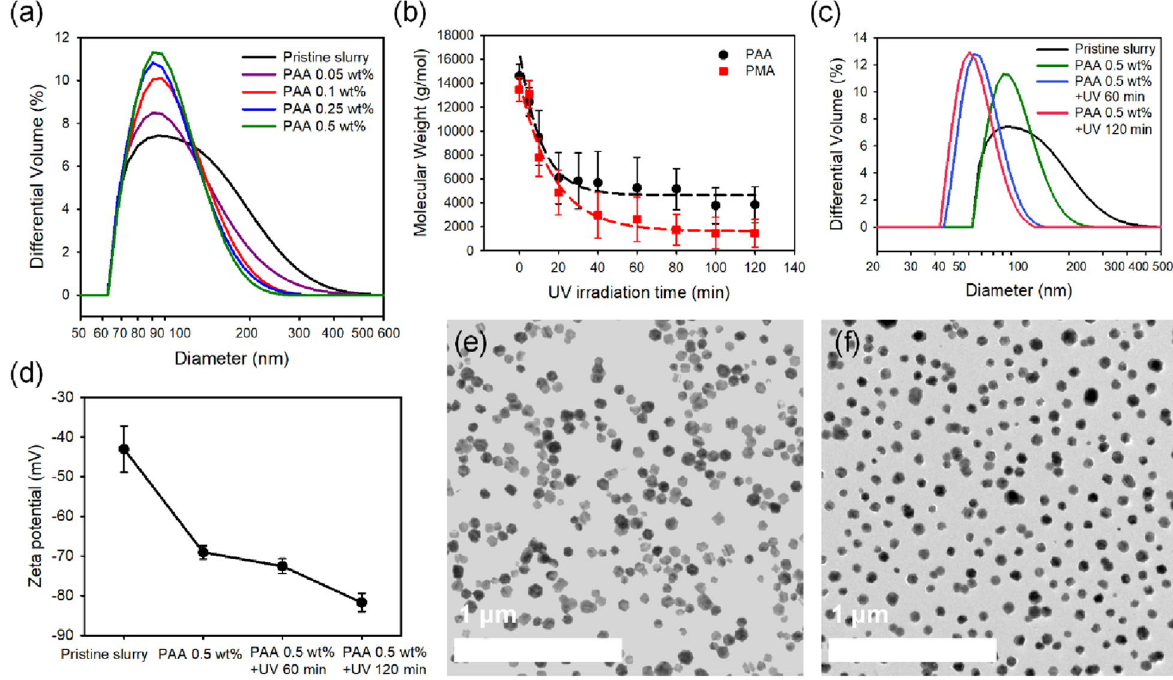
Figure 5. ( a ) Particle size distribution of ceria slurry according to the addition of PAA with various concentrations. The improvement of dispersity through photo-oxidative degradation of polyacids was verified by measuring the changes in ( b ) molecular weight of poly acids due to the photo-oxidative degradation of polyacids, ( c ) particle size distribution, and ( d ) zeta potential of ceria slurry according to UV irradiation time with fixed PAA concentration of 0.5 wt.%. TEM images of ( e ) pristine ceria slurry and ( f ) UV irradiated ceria slurry with polyacids confirms the dispersity of the